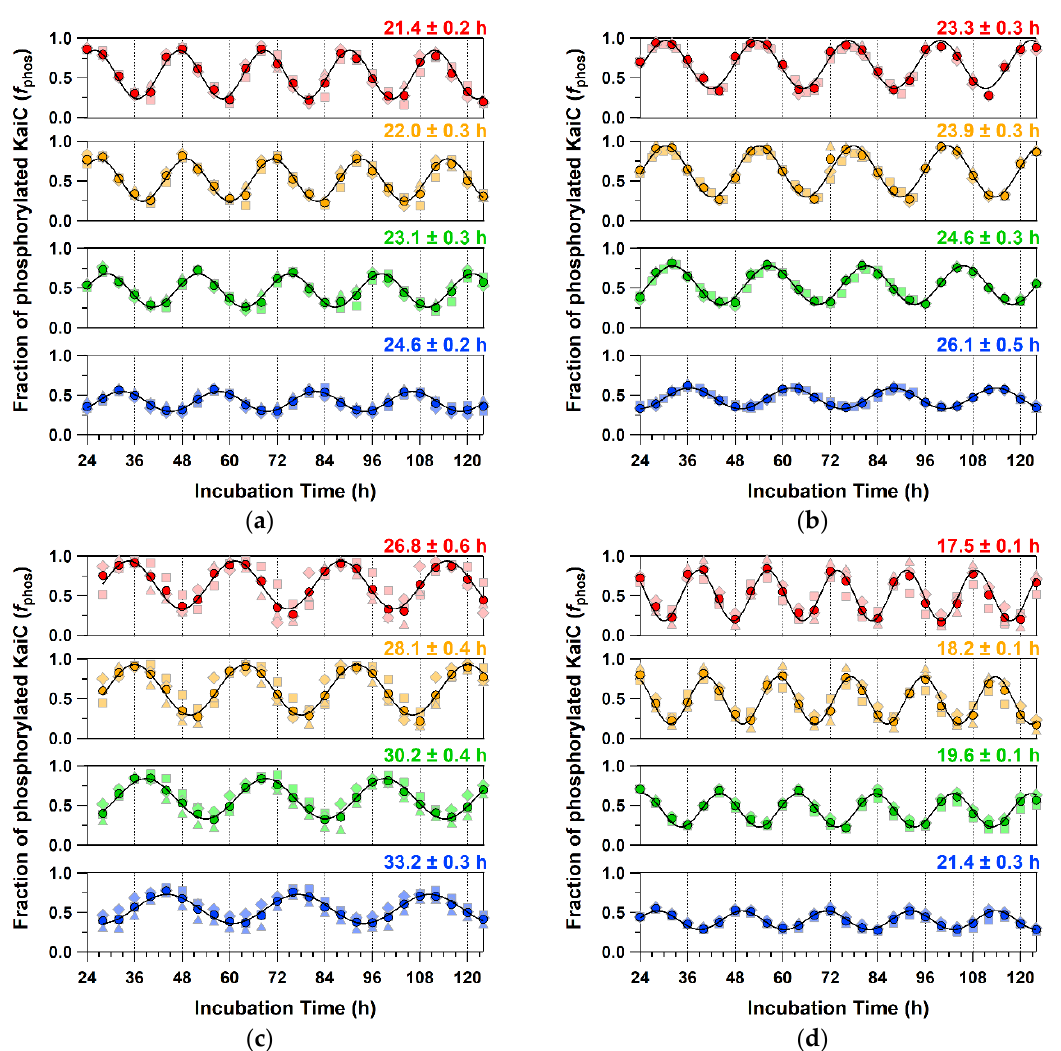
Figure 4. Phosphorylation/dephosphorylation cycles of ( a ) KaiC-WT, ( b ) KaiC-P37A, ( c ) KaiC-T228A, and ( d ) KaiC-C306A at different temperatures. Blue, green, orange, and red markers correspond to the fractions of phosphorylated KaiC ( f phos ) at 25, 30, 35, and 40 °C, respectively. Dark-colored circles correspond to the mean from independent preparations and measurements (pale-colored squares, triangles, and diamonds). Thin lines represent the fitting of the mean to Equation (1) described in Materials and Methods.